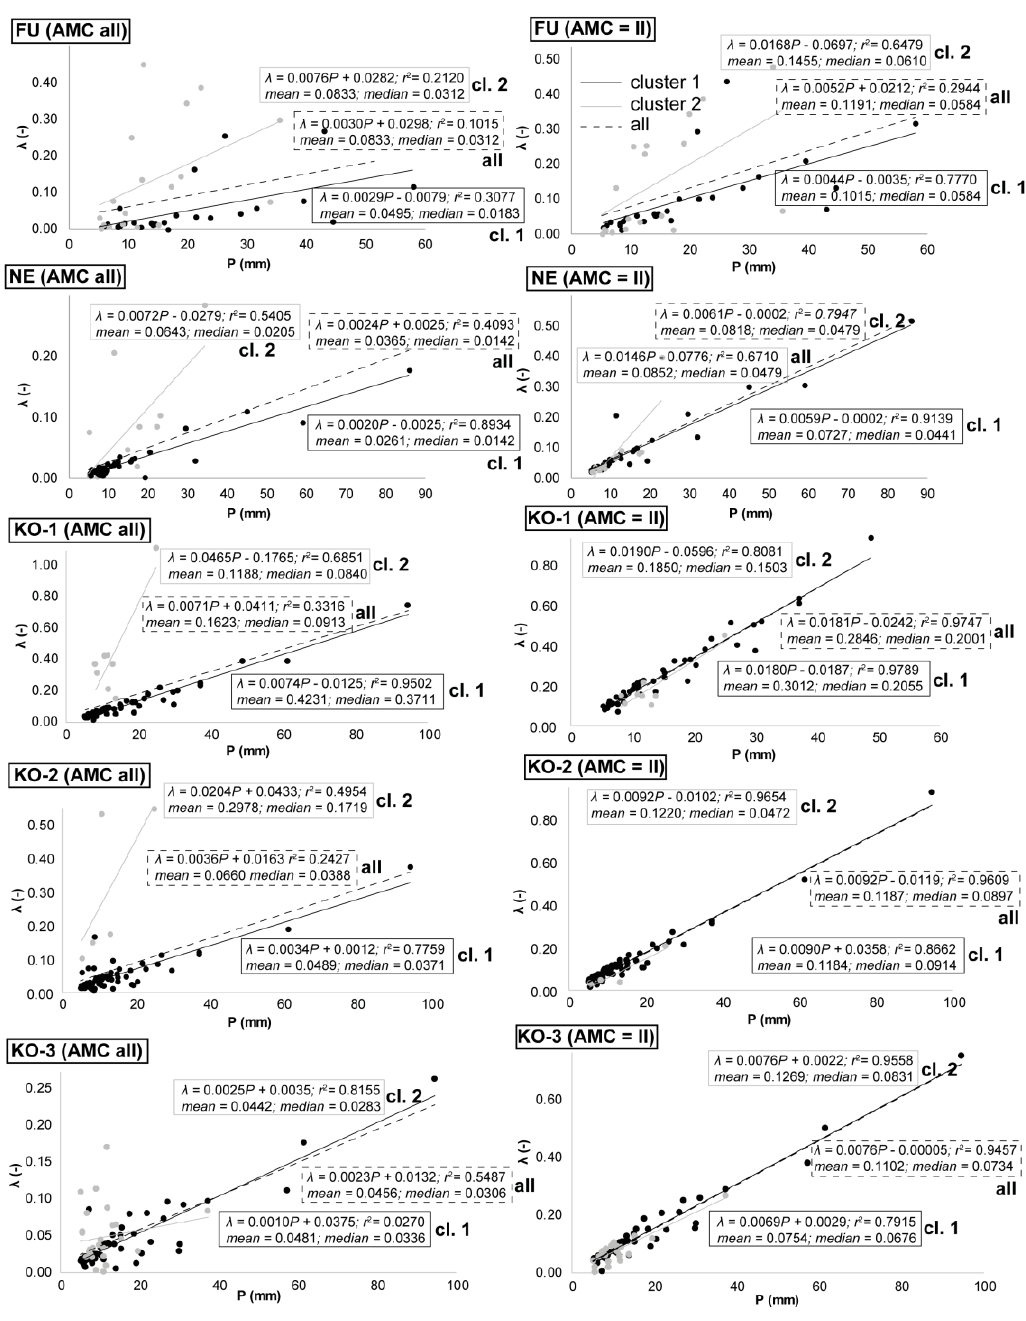
Figure 4. Initial abstraction coefficient λ expressed as linear function of precipitation height P for the experimental catchments and for AMC classified (AMC all) and normal only (AMC = II).